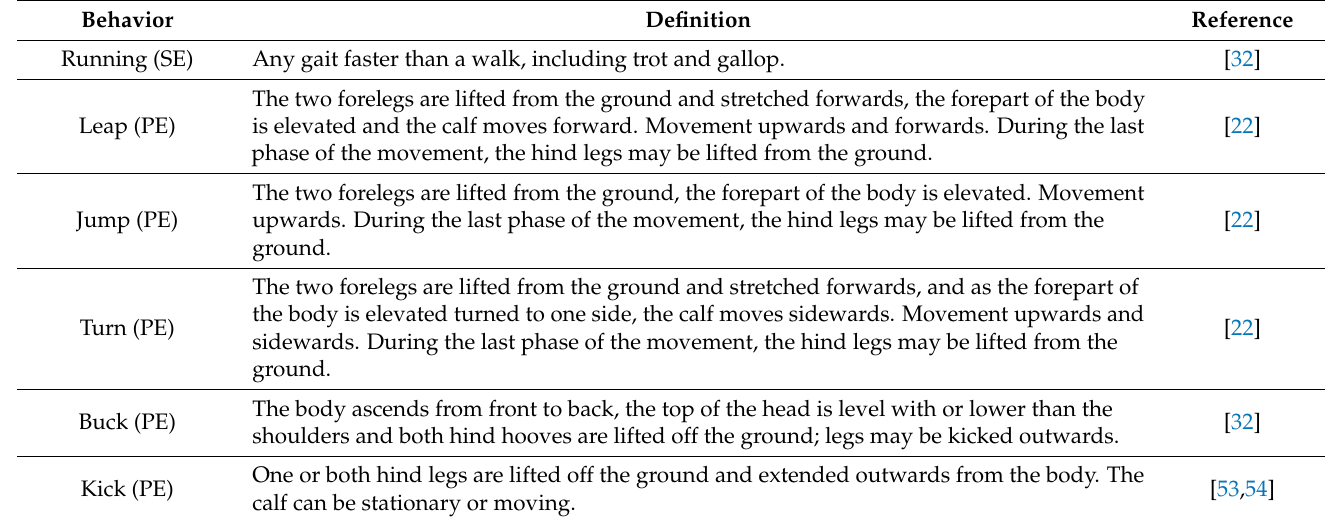
Table 1. Ethogram of locomotor play behaviors in Friesian dairy calves. SE: State Event; PE: Point Event. Behavior Definition